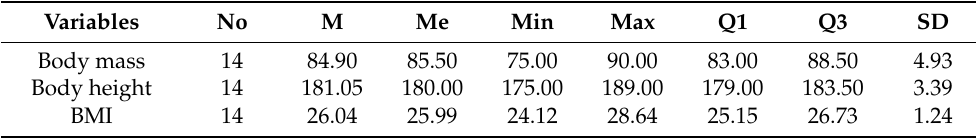
Table 1. Anthropometric measures of study